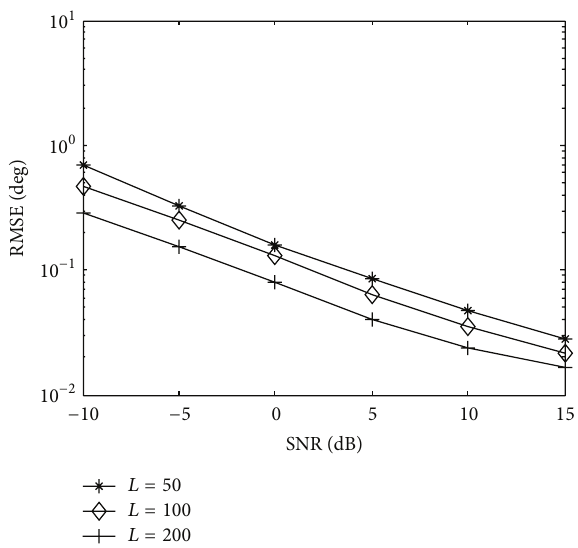
Figure 10: Angle estimation performance of our algorithm with different 𝐿 ( 𝑁 = 16 , 𝑀 = 20 , and 𝐾 = 3